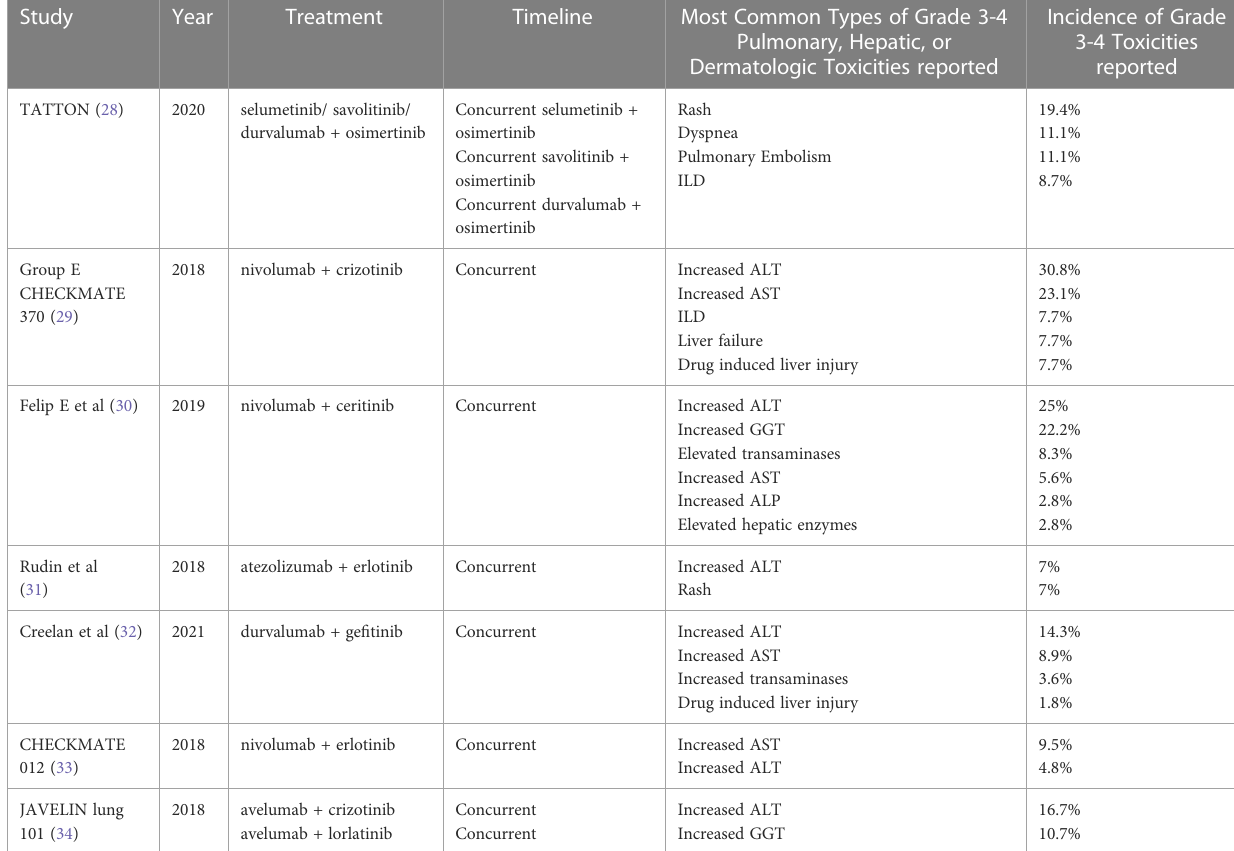
TABLE 1 Studies with ICI and TKI treatment with the Timeline, Type, and Incidence of Toxicities Reported.